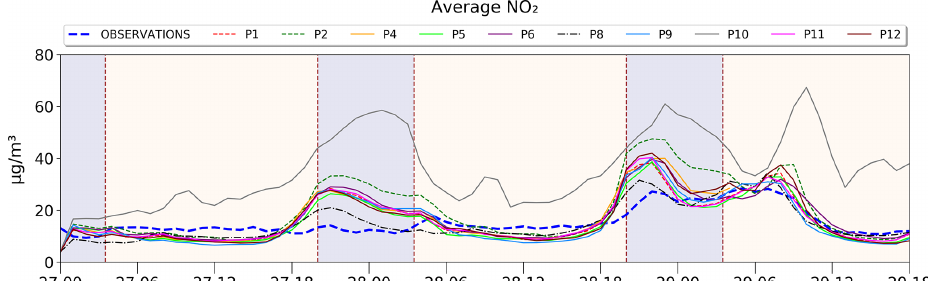
Figure 10. Evaluation of modeled NO ∗ concentrations (corrected to account for interference of other NO y species; see the text) using station 2 data over the 3d simulation period. Both the model data and observations are averages over 24 stations within the inner domain. The thick dashed line represents the measurements, while the other curves represent the different PBL runs. The vertical dashed lines separate night- and daytime, shaded in blue and orange, respectively.